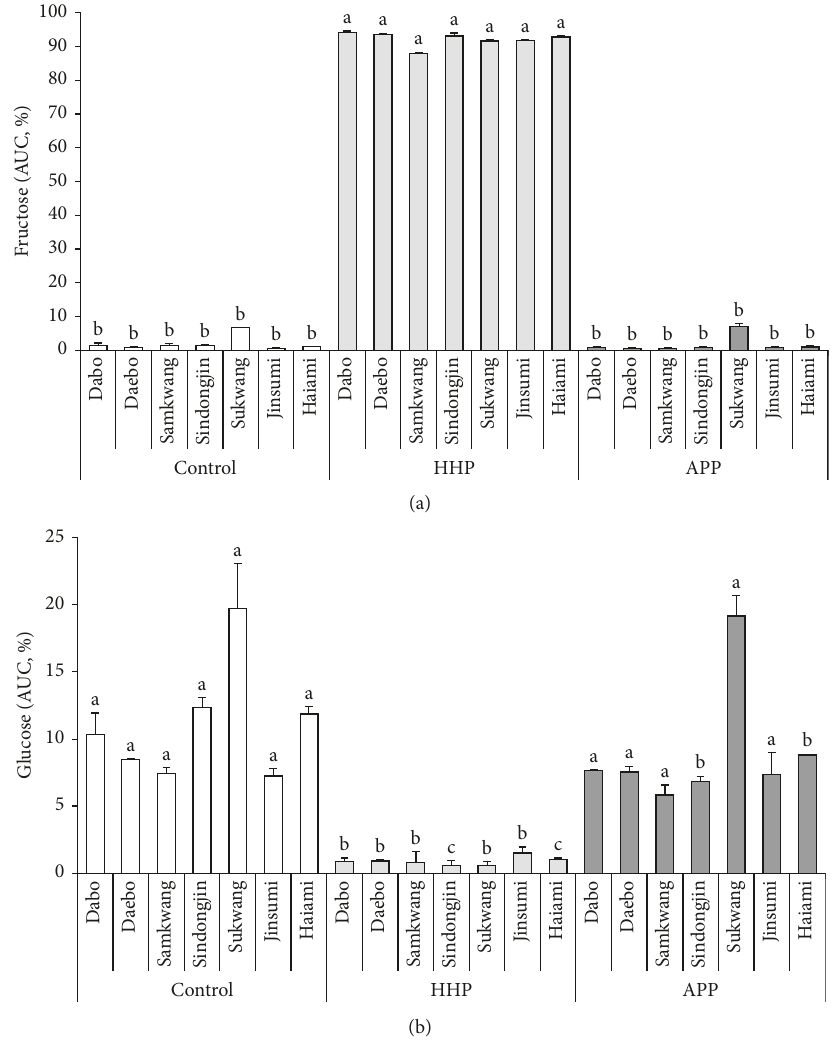
0 . 05 according to Tukey’s multiple range tests within <